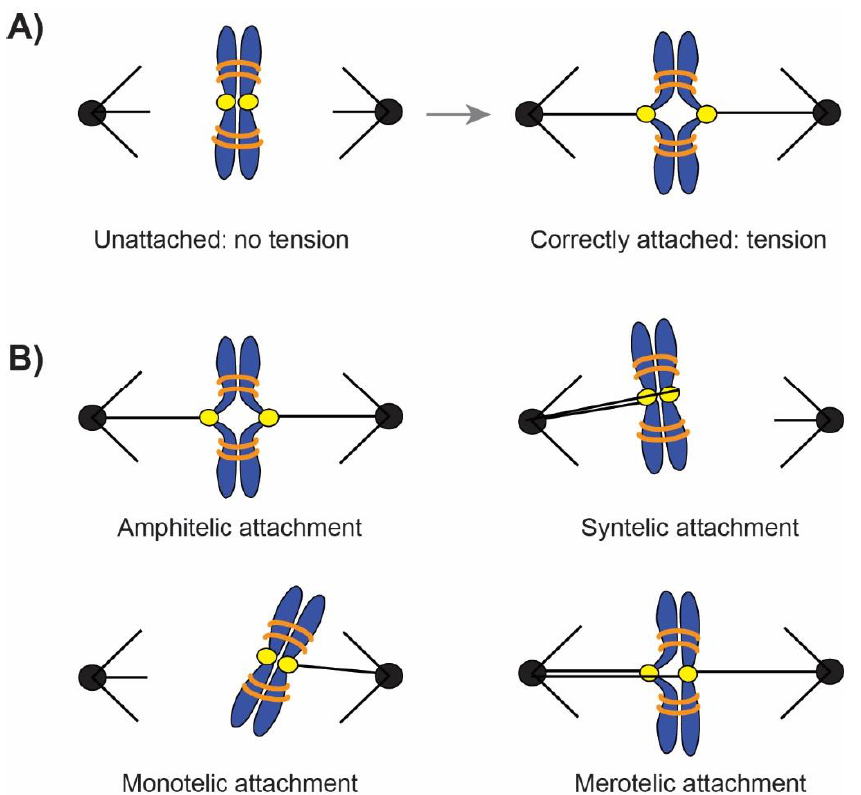
Figure 1. Attachment of chromosomes (blue) to the spindle (black) is facilitated by kinetochores (yellow). Sister chromatids are held together by cohesin (orange). ( A ) Unattached chromosomes experience no tension, but when they are correctly attached or bi-oriented, they experience tension force as the two chromatids are pulled apart by depolymerizing microtubules but resisted by cohesin. Both pericentric chromatin and kinetochores on bi-oriented chromosomes become visibly stretched under tension. ( B ) Correct attachments are also referred to as amphitelic attachments with kinetochores on sister chromatids attached to microtubules from opposite spindle poles. Incorrect attachments include: syntelic attachment where kinetochores on sister chromatids are attached to the same pole, monotelic attachment where only a single kinetochore is attached, and merotelic attachment where a kinetochore is attached to both poles. Incorrect attachments generate no tension (syntelic and monotelic) or improper tension (merotelic) on the chromosome.